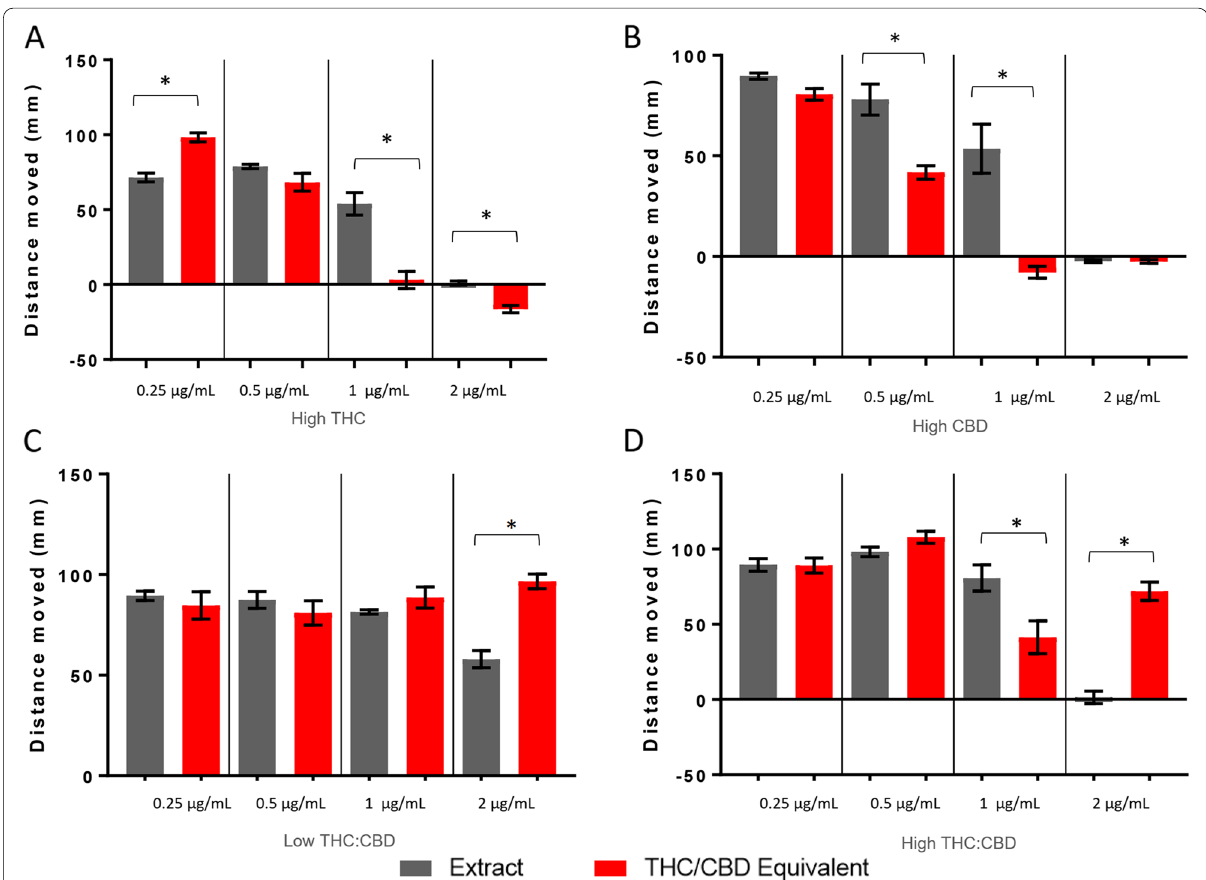
Fig. 5 Larval locomotion following exposure to high THC, high CBD, low‑temp THC:CBD, and high‑temp THC:CBD extracts. Larval locomotion following exposure to extracts and equimolar THC/CBD equivalents at varying concentrations is presented as the difference in the average distance traveled between the first 5 min dark cycle and the preceding 5 min light experimental control as measured by ANOVA followed by a Bonferroni post hoc test ( p <